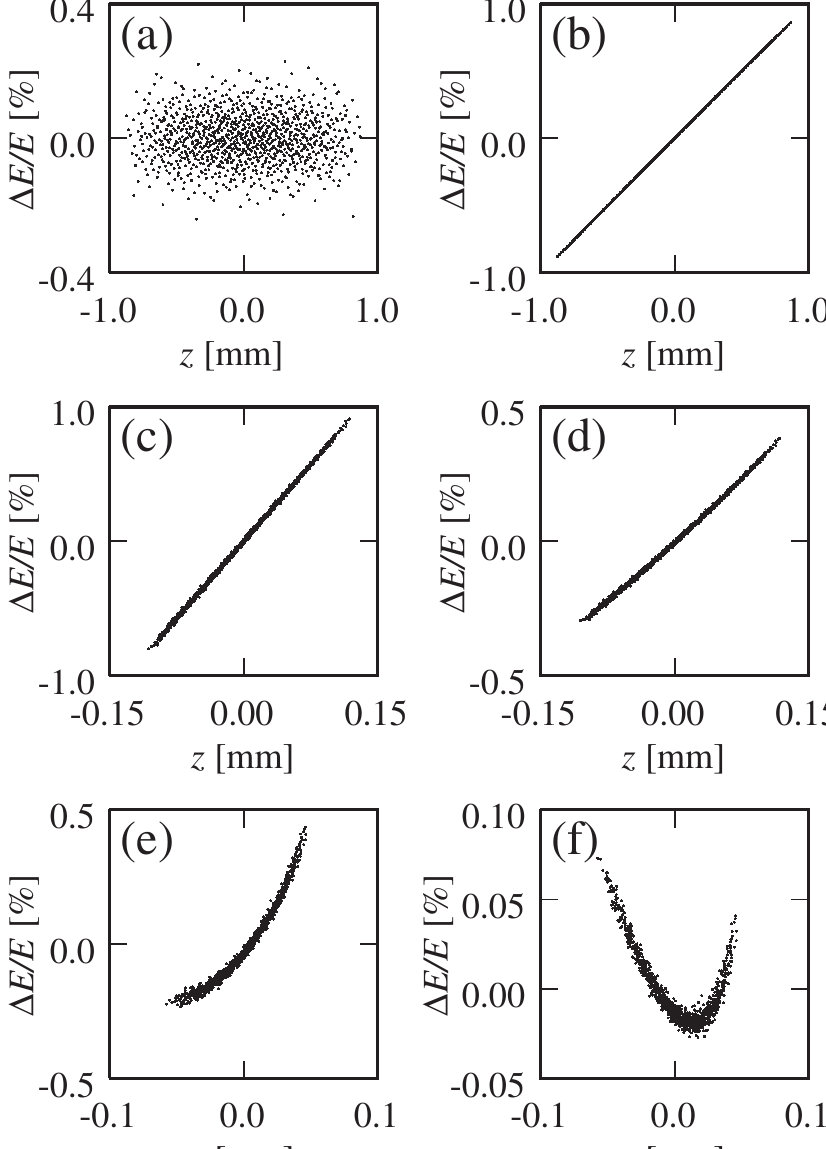
FIG. 7. Bunch compression for an initial parabolic current distribution with rms length of 400 (cid:2) m and charge of 200 pC. The longitudinal phase space evolution is given by ELEGANT simulations of 100 000 particles that include the coherent-radiation wakes of both chicanes in addition to the geometric wakes of the L1 and L2 linacs. (a) Initial bunch at 4 MeV. (b) Chirped bunch at the entrance of the BC1 chicane. (c) Bunch after single-stage compression in BC1. (d) Chirped bunch at the entrance of the BC2 chicane. (e) Bunch after full compression in BC2. (f) Dechirped bunch at 1.7